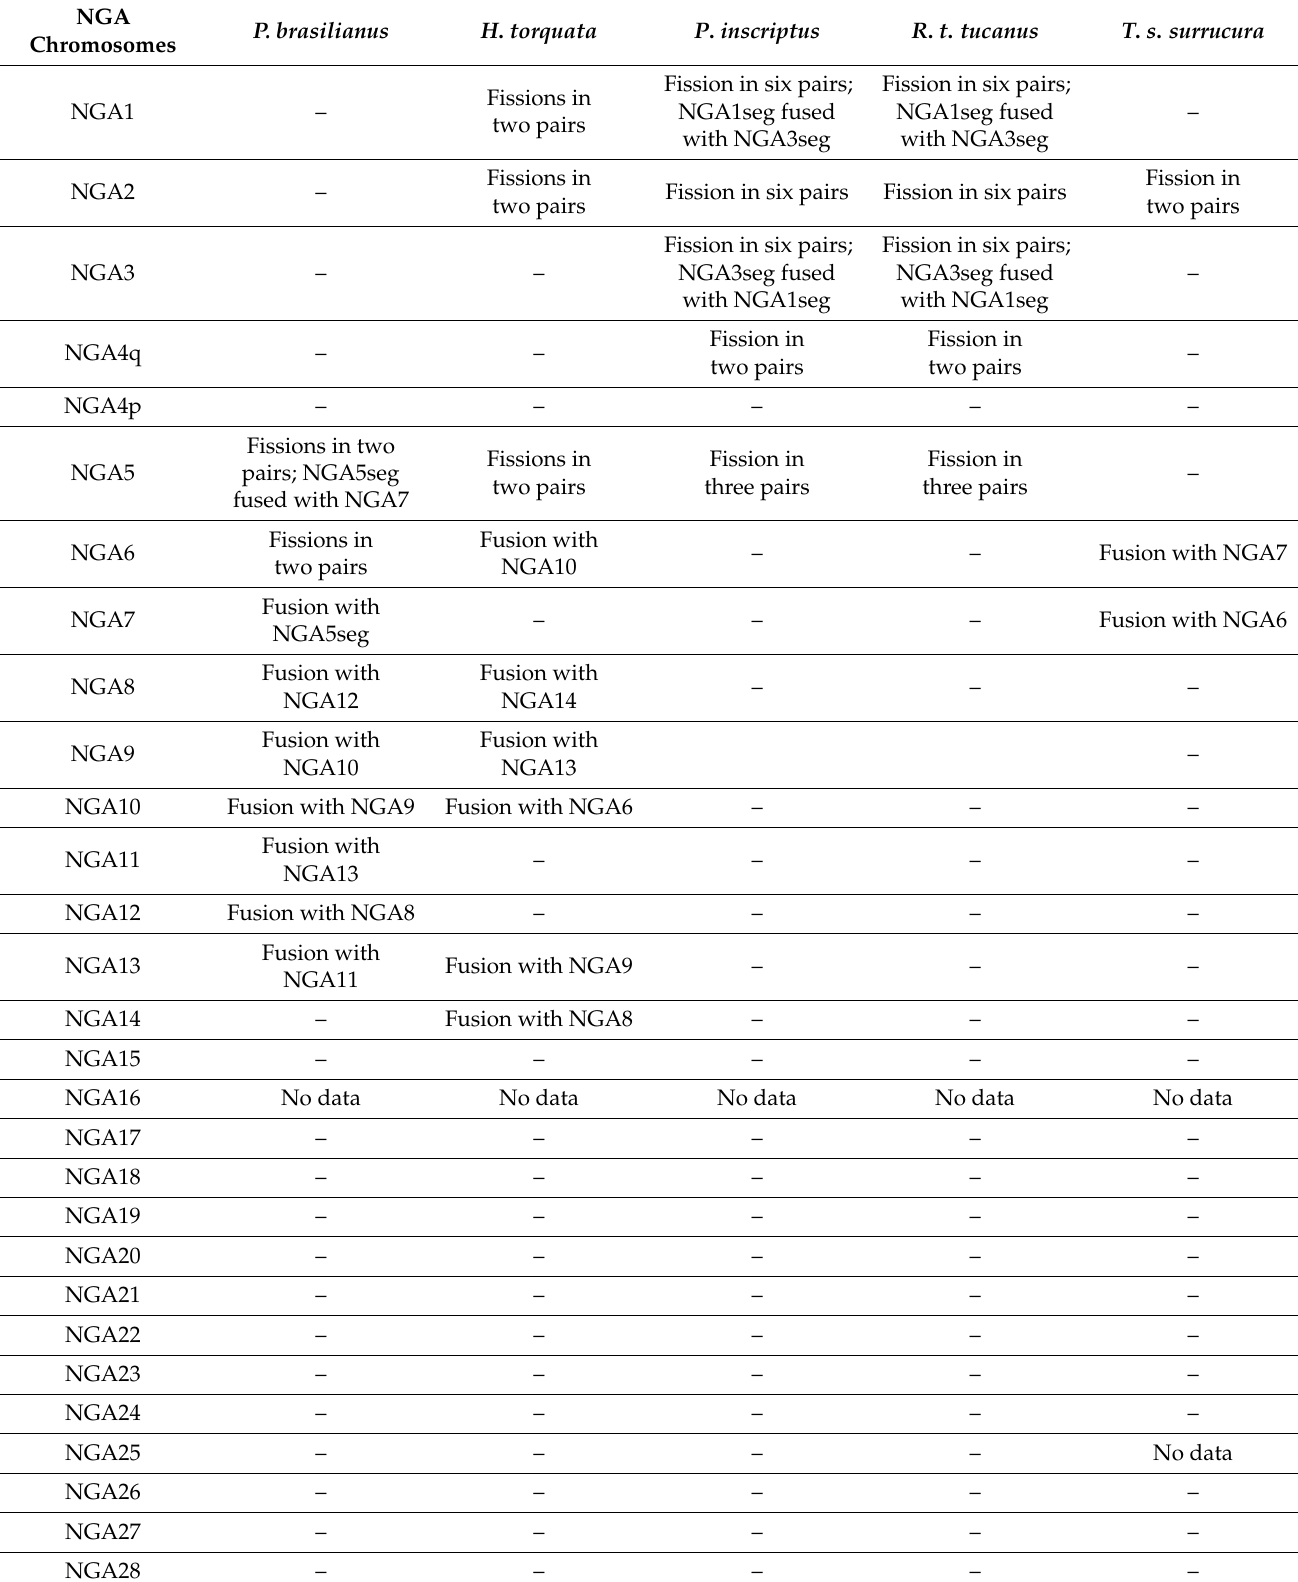
Table 2. Patterns of interchromosomal rearrangements revealed in the karyotype of five species of Neoaves birds. NGA